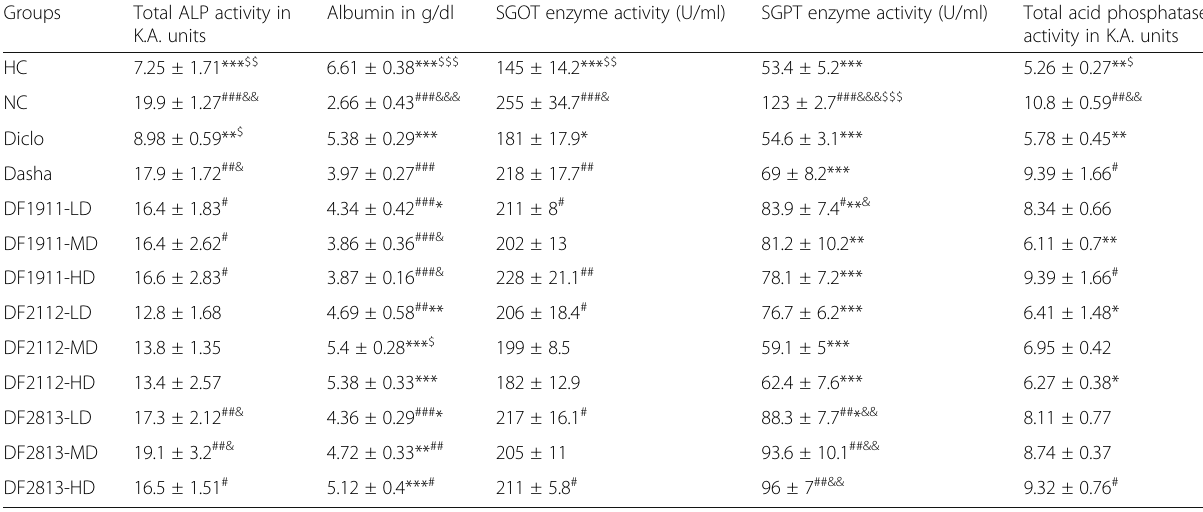
HC healthy control, NC negative control, Diclo diclofenac sodium, Dasha Dashamoola Kwatha , DF Dashamoola formulation, LD lower dose, MD middle dose, HD higher dose, ALP alkaline phosphatase, SGOT serum glutamic-oxaloacetic transaminase, SGPT serum glutamic-pyruvic transaminase. Values are expressed as Mean ± SEM; n = 6. Data were analysed by One-Way ANOVA followed by Dunnett ’ s multiple comparison test. # = p < 0.05, ## = p < 0.01, ### = p < 0.001 when compared to HC; * = p < 0.05, ** = p < 0.01, *** = p < 0.001 when compared to NC; & = p < 0.05, && = p < 0.01, &&& = p < 0.001 when compared to Diclo;